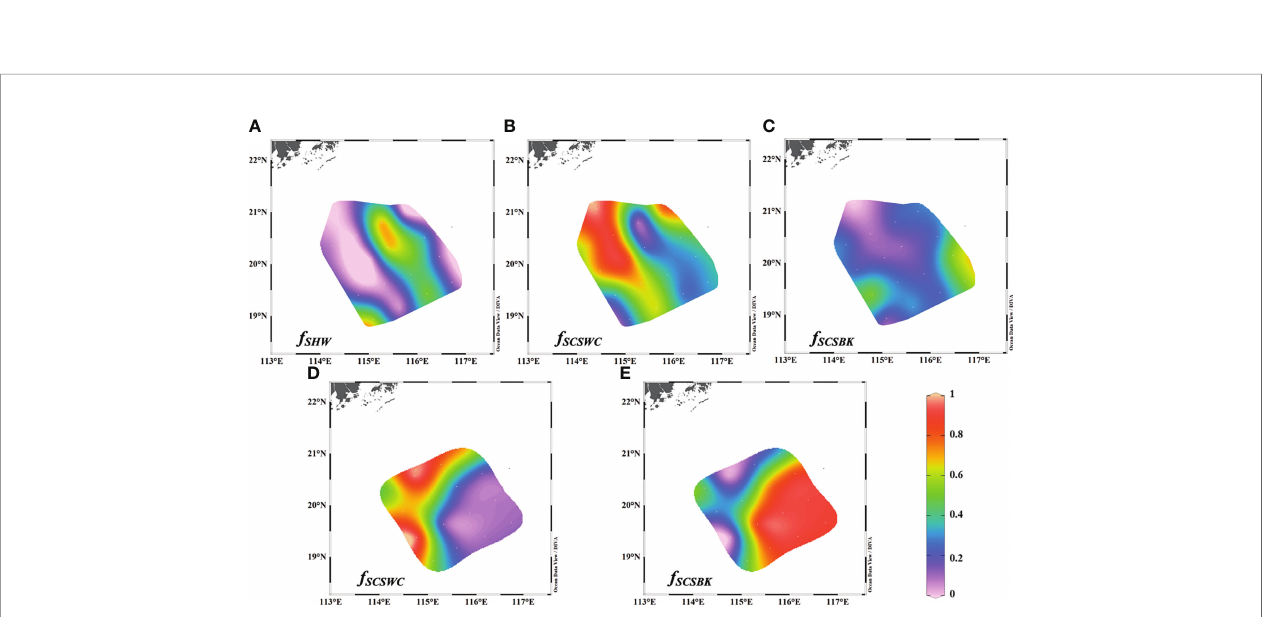
FIGURE 7 | Fractions of SHW, SCSWC, and SCSBK in the surface water of our study area of interest in the NSCS during (A – C) June 2015 and (D, E) March